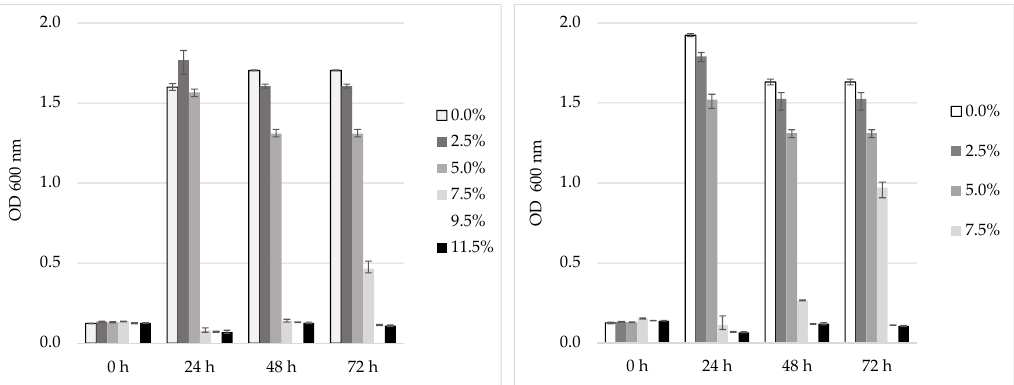
Figure 4. Tolerance to di ff erent NaCl concentrations of Kombucha L3 ( left ) and L5 ( right ) LAB isolates. Data shown are mean ± SD of triplicate values of independent